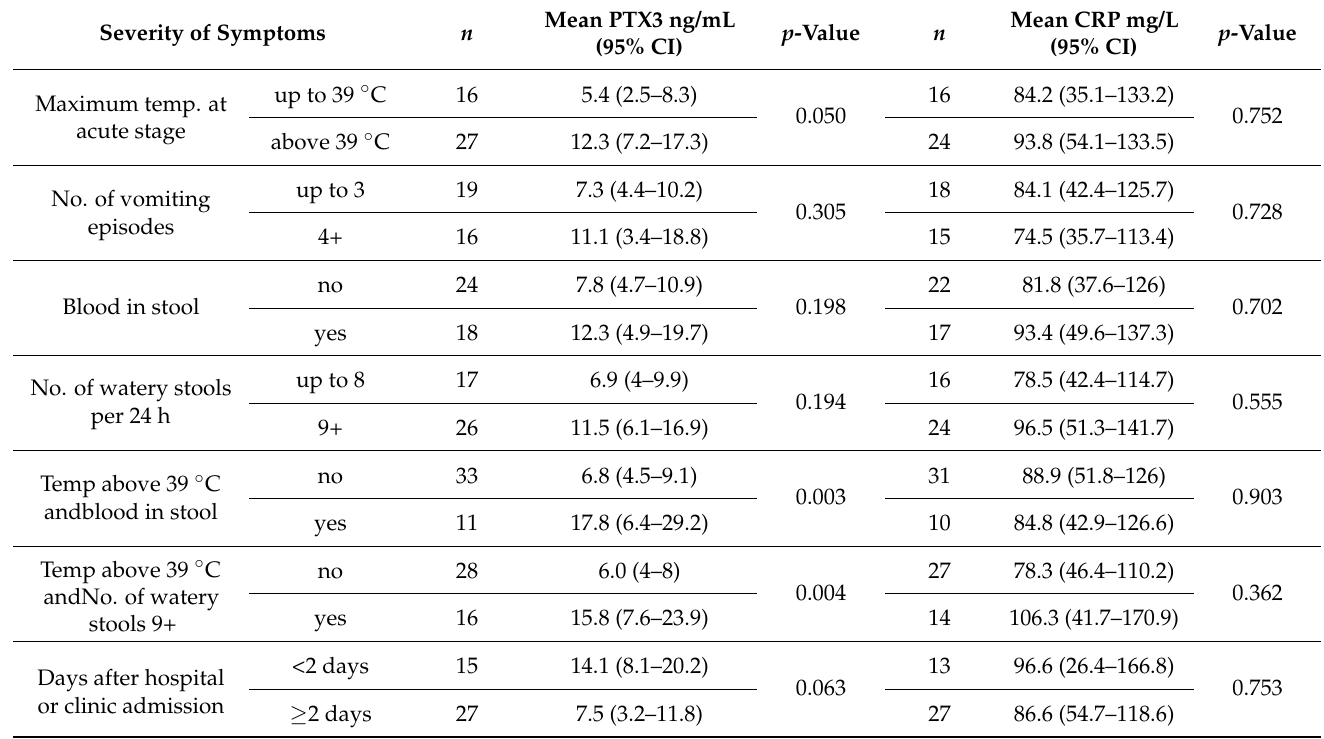
Table 2. Clinical manifestation of disease, days after onset, and level of PTX3 and CRP in serum samples of acute cases of S. sonnei shigellosis.